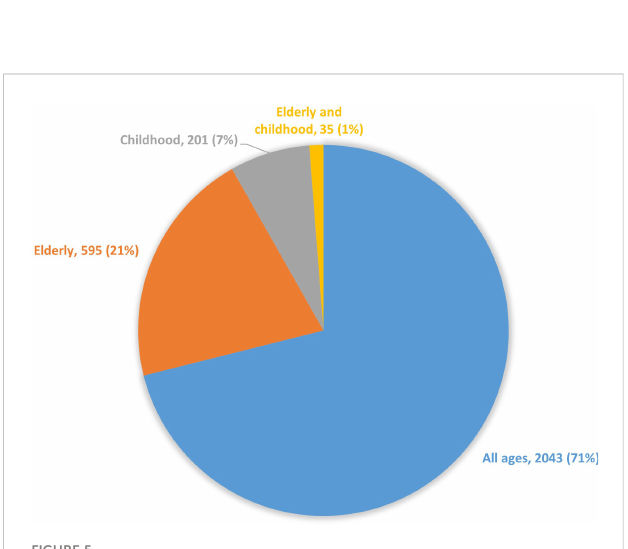
FIGURE 5 Number of articles on cancer treatment by age group, 1975-2022.